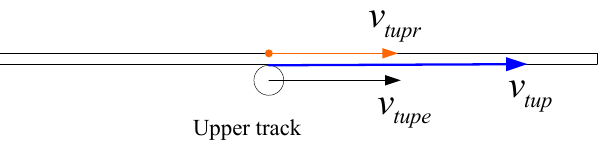
Figure 7. Upper part of the track.